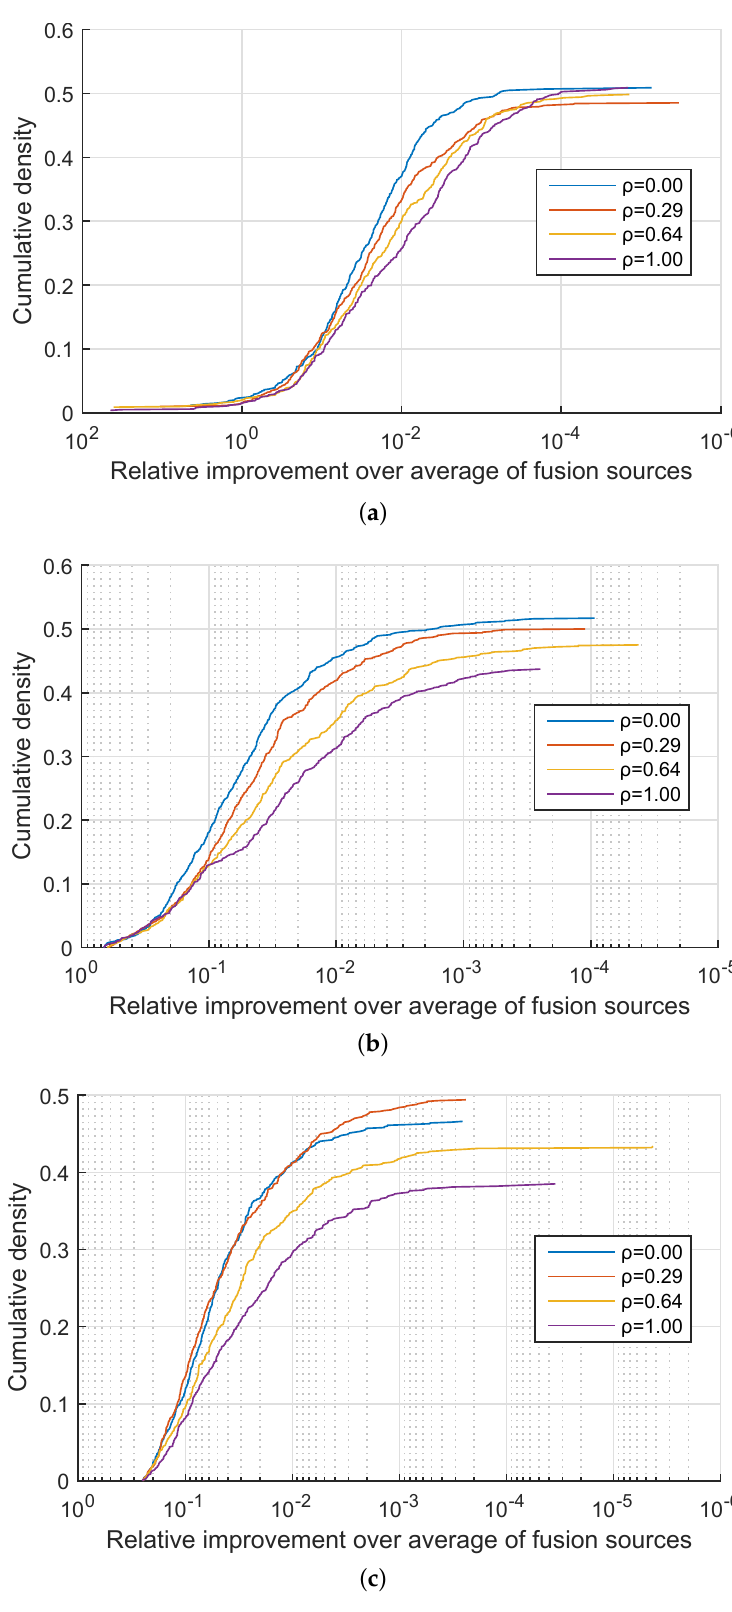
Figure 2. Synthetic data: relative improvement in the confidence of the correct information source identification of the proposed quadratic mean-based fusion over linear fusion, as the corresponding cumulative distribution function. ( a ) β n = 0.32, d = 0.10; ( b ) β n = 0.32, d = 2.28; ( c ) β n = 0.32, d =